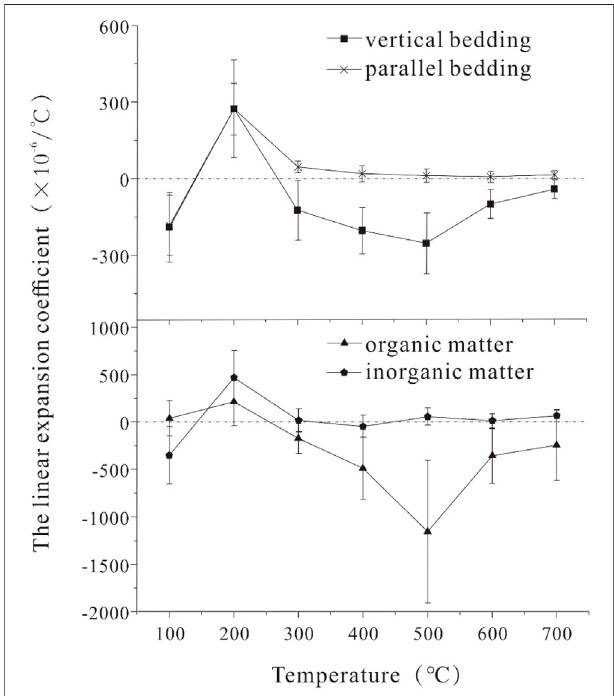
FIGURE 10 | The linear thermal expansion coef fi cient of shale as a function of temperature.